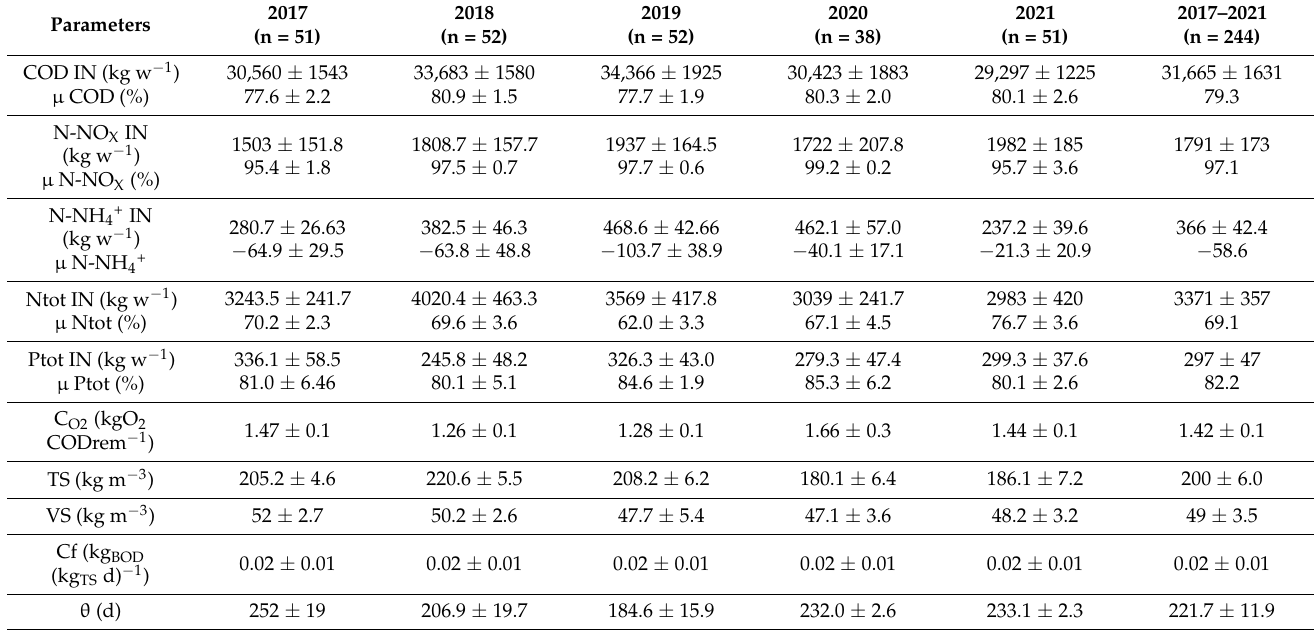
Table 1. Loads of pollutants fed and performance of the thermophilic system. n: number of